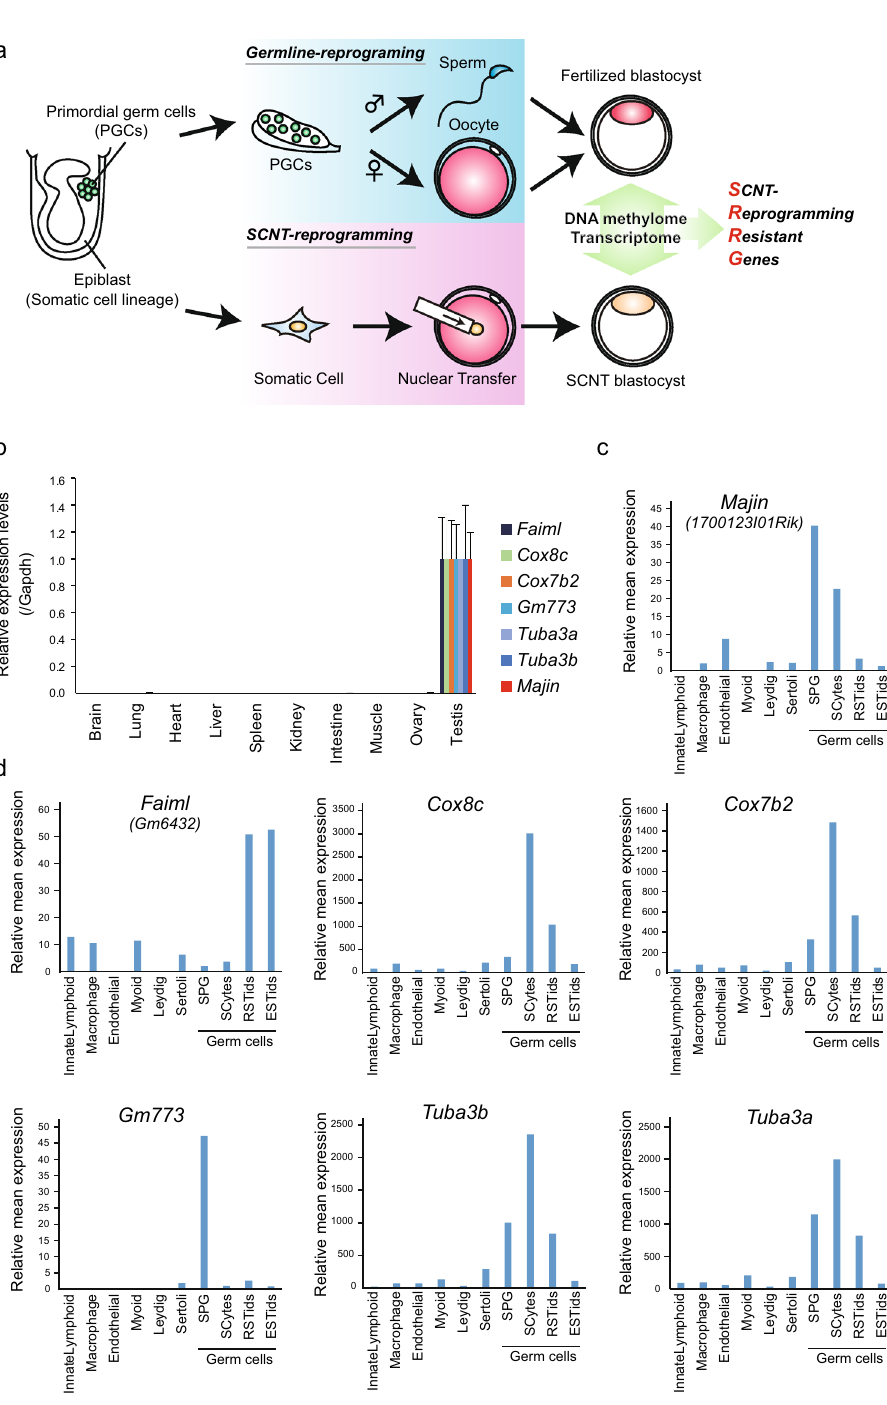
Figure 1. Testicular germ cell-specific expression of target SRRGs. ( a ) Schematic illustration comparing germline reprogramming and somatic cell nuclear transfer (SCNT) reprogramming and the strategy to identify SCNT-reprogramming resistant genes (SRRGs). Germ cells that are differentiated from epiblast as primordial germ cells undergo germline-specific epigenetic reprogramming through either spermatogenesis or oogenesis. In SCNT, on the other hand, the somatic cell genome skips germline reprogramming, instead undergoing SCNT reprogramming in the ooplasm. Therefore, it is assumed that SCNT embryos possess epigenetic abnormalities that are resistant to SCNT reprogramming, but are successfully reprogrammed only in the germline (see Supplementary Table S1 and Matoba et al. 25 ). ( b ) RT-qPCR analysis of gene expression levels of target SRRGs and Majin in adult mouse tissues. Data shown are mean expression values relative to Gapdh . The expression level of each gene was normalized for testis as 1. ( c , d ) Bar graphs showing the gene expression levels of Majin ( c ) and target SRRGs ( d ) in multiple cell types of adult testes. Single-cell RNA-seq data were obtained from Green et al. 32 . SPG, spermatogonia; SCytes, spermatocytes; RSTids, round spermatids; ESTids, elongated spermatids. Note that Majin and SRRGs are highly expressed in germ cells in a stage-specific